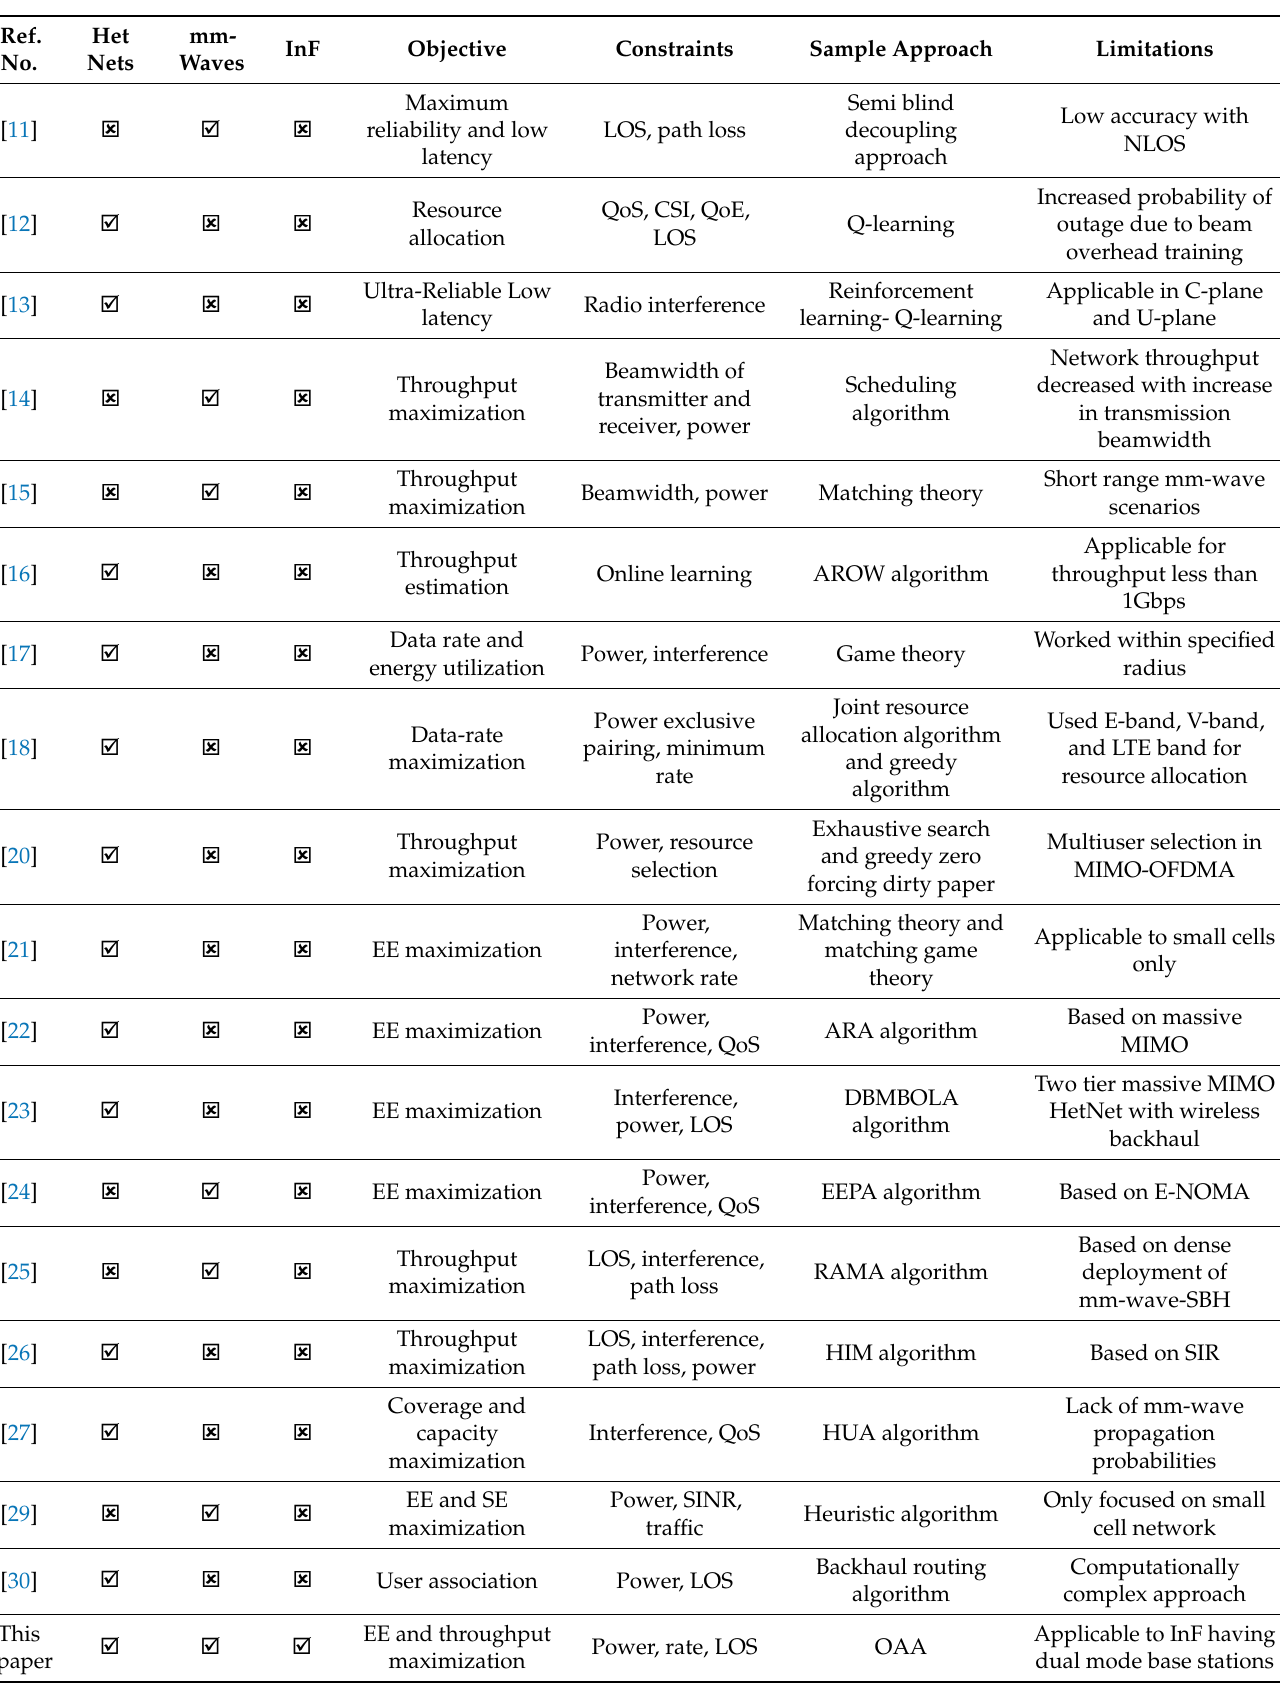
Table 1. Summary of the existing mm-wave resource allocation techniques.